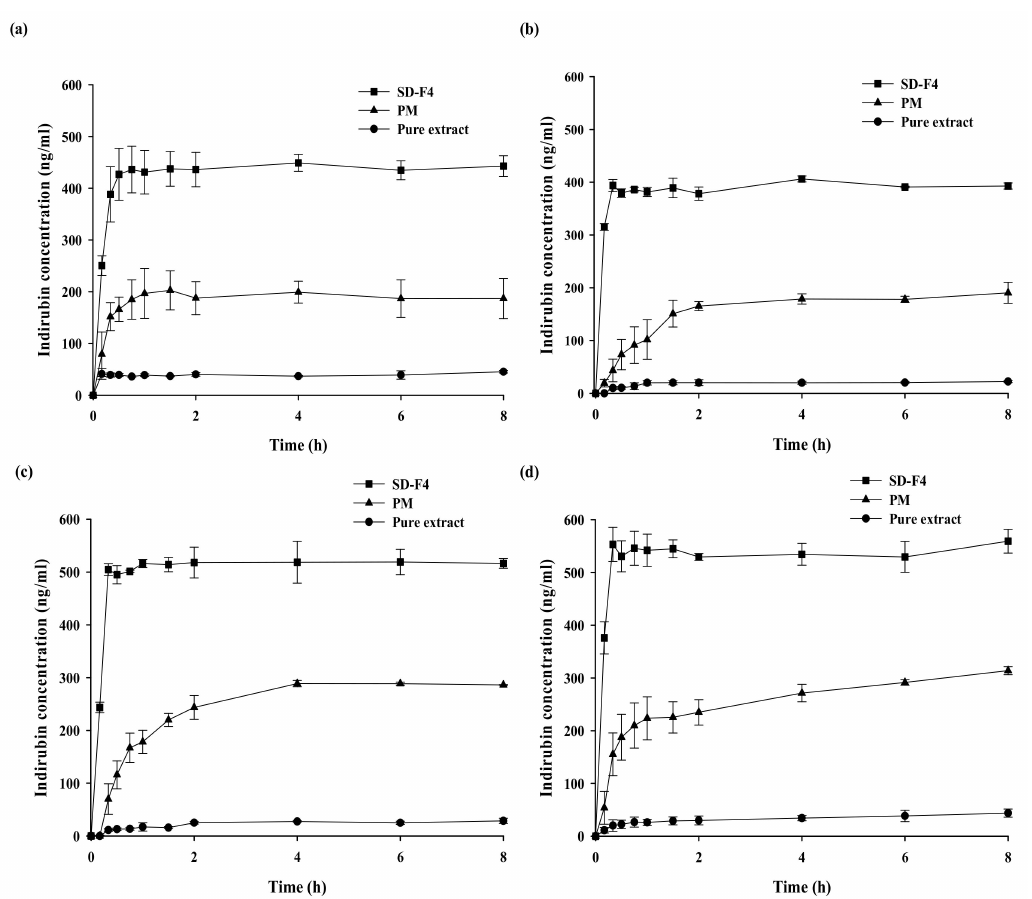
Figure 5. Dissolution profiles of indirubin from SD-F4, pure extract (pure MT-102), and physical mixture (PM) at various pH levels (mean ± s.d., n = 3). ( a ) Water, ( b ) pH 1.2, ( c ) pH 4.5, and ( d ) pH 6.8.